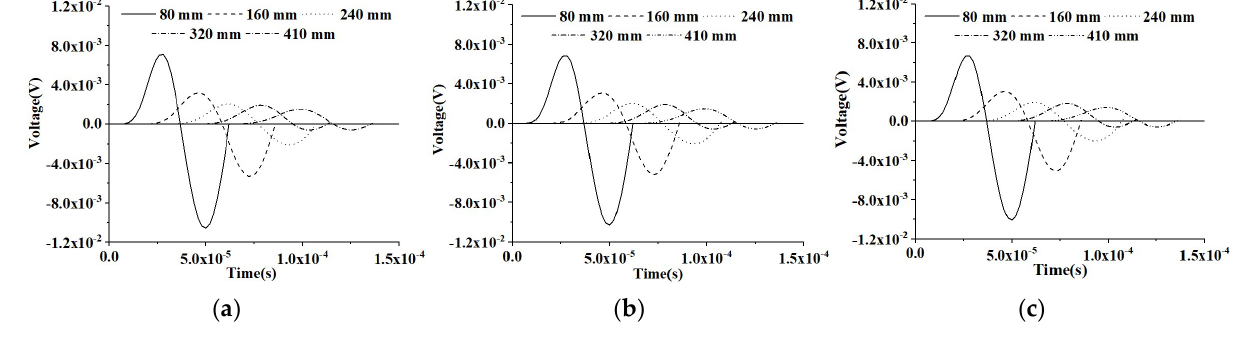
Figure 10. Responses of PZT sensors at different measurement distances from the actuator under sinusoidal excitation of three CHFEMs corresponding to the healthy CMFEM 1 with different RAE dimensions: ( a ) 20 mm; ( b ) 25 mm; ( c ) 40 mm. dimensions: ( a ) 20 mm; ( b ) 25 mm; ( c ) 40 mm.